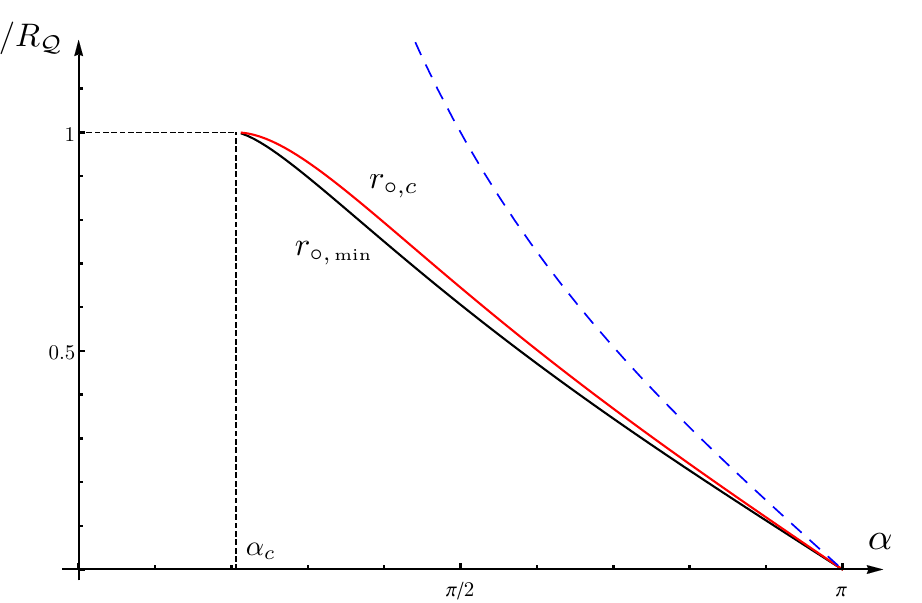
Figure 8 . The solid black curve is the minimal value r (cid:14) ; of R (cid:14) =R Q , below which the local min solutions ^ (cid:13) con intersecting Q orthogonally do not exist (see also (cid:12)gure 5), in terms of (cid:11) > (cid:11) c . The A solid red curve gives the value r (cid:14) ;c > r (cid:14) ; of R (cid:14) =R Q for (cid:11) > (cid:11) c corresponding to the critical min con(cid:12)guration where ^ (cid:13) con A entropy. The dashed blue curve is the asymptotic value